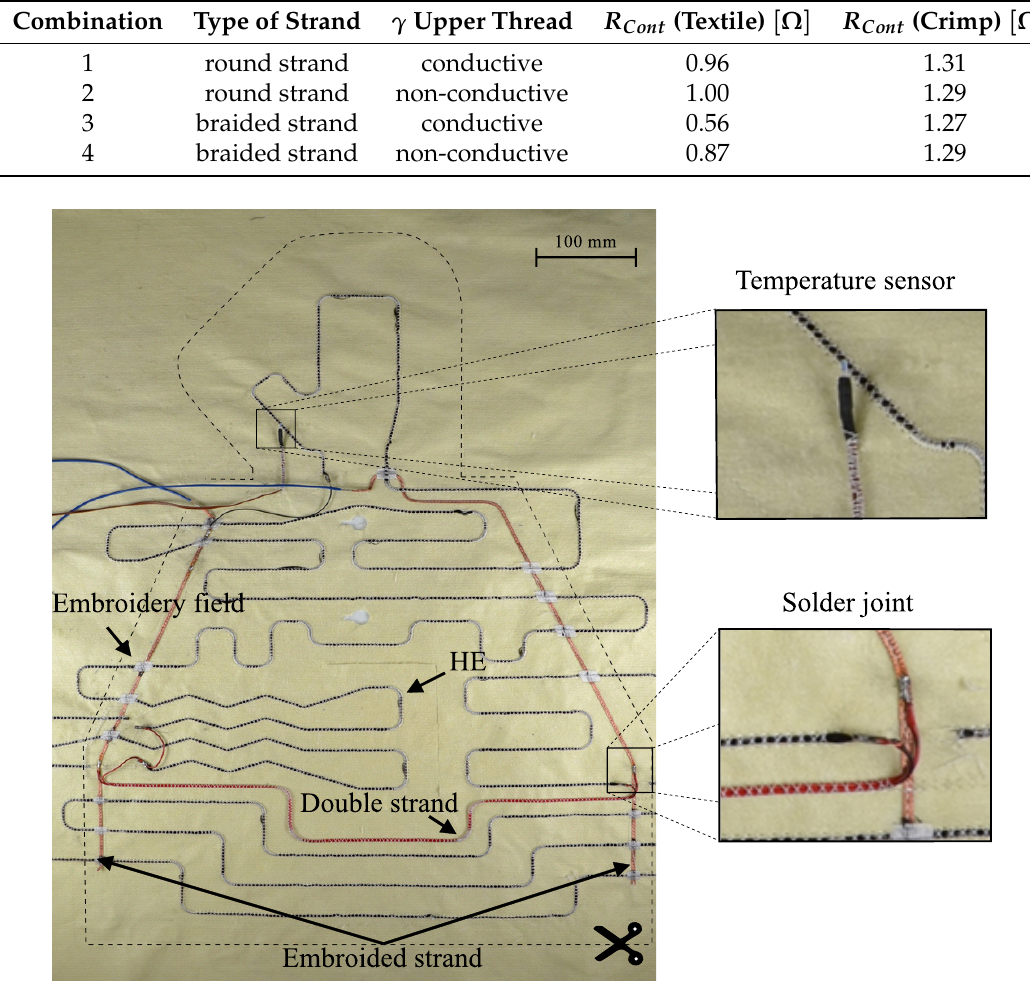
Figure 11. Warming layer with integrated functional